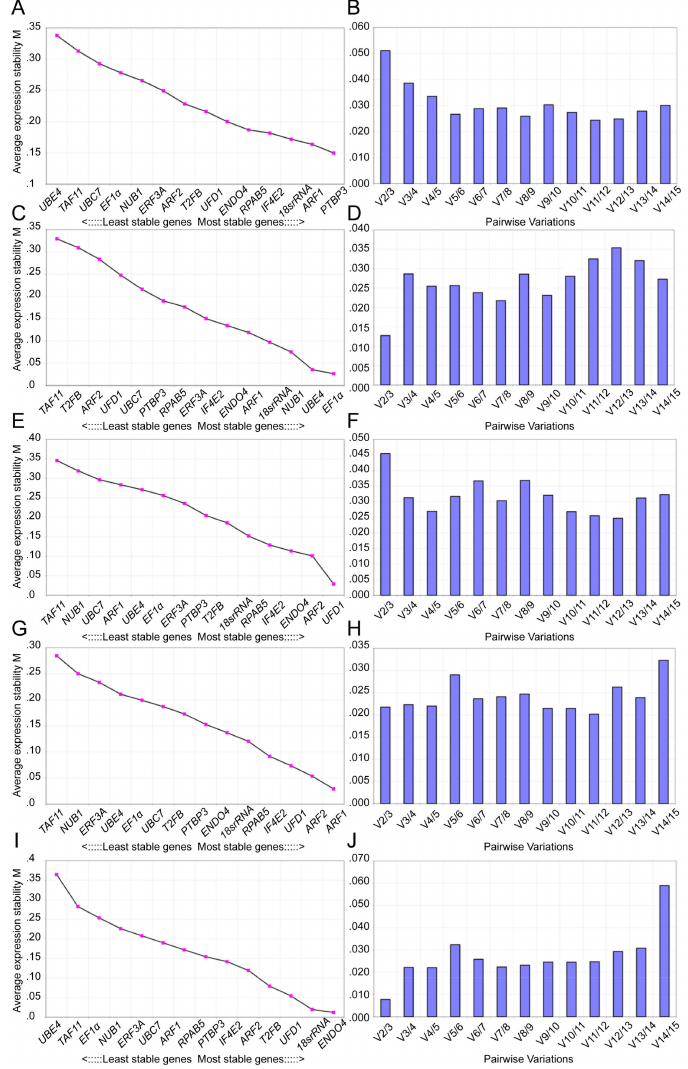
Figure 3. geNorm analysis of the values of average expression stability (M) and pairwise variation (Vn / Vn + 1) for the candidate reference genes. M and pairwise variation (Vn / Vn + 1) were calculated on the basis of 2 − ∆ Ct ( ∆ Ct = the corresponding Cq value – minimum Cq) by geNorm. Lower M values indicate more stable gene expression. Ranking of the gene expression stability was determined in presented samples. According to the algorithm and software instructions, the cut-o ff V value of 0.15 was used to determine the optimal number of reference genes for RT-qPCR normalization. ( A–B ) Values of M and Vn / Vn + 1 for the reference genes in the four cotton cultivars. ( C–D ) Values of M and Vn / Vn + 1 for the reference genes in YZ1. ( E–F ) Values of M and Vn / Vn + 1 for the reference genes in R15. ( G–H ) Values of M and Vn / Vn + 1 for the reference genes in X33. ( I–J ) Values of M and Vn / Vn + 1 for the reference genes in